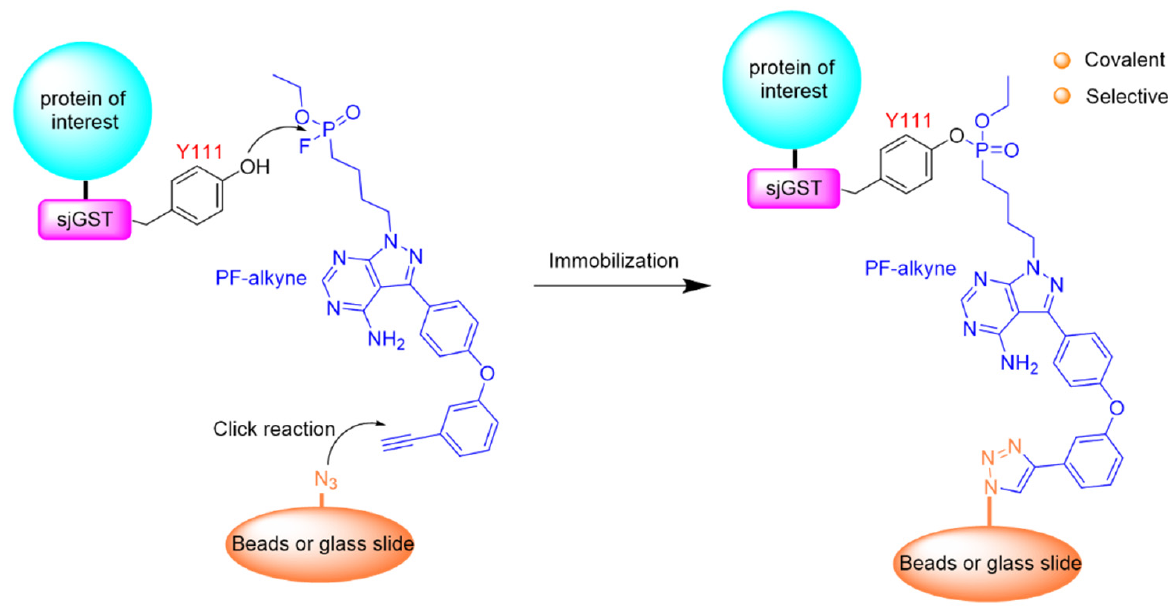
Figure 7. Site-selective immobilization of sjGST-tagged proteins containing the tyrosine residue 111 through a small pyrimidine-based molecule with a fluorophosphonate-reactive group in the bead. Reprinted with permission from [130]. Copyright (2018) Royal Society of Chemistry.